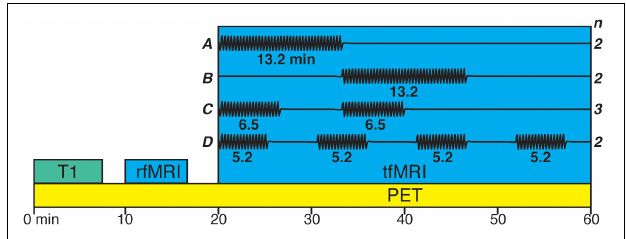
FIGURE 1 | Variations of the finger tapping task paradigm. Black line in (A–D) represents blocks of tapping. Two participants had a single block (13.2 min; A ) with the onset 20 min from PET acquisition start. Two participants had a single block (13.2 min; B ) with the onset 33.33 min from PET acquisition start. Three participants had two blocks (6.5 min; C ) with the onset 20 and 33.33 min from PET acquisition start. Two participants had four blocks (5.2 min; D ) with the onset 20, 30.66, 41.33, and 52 min from PET acquisition